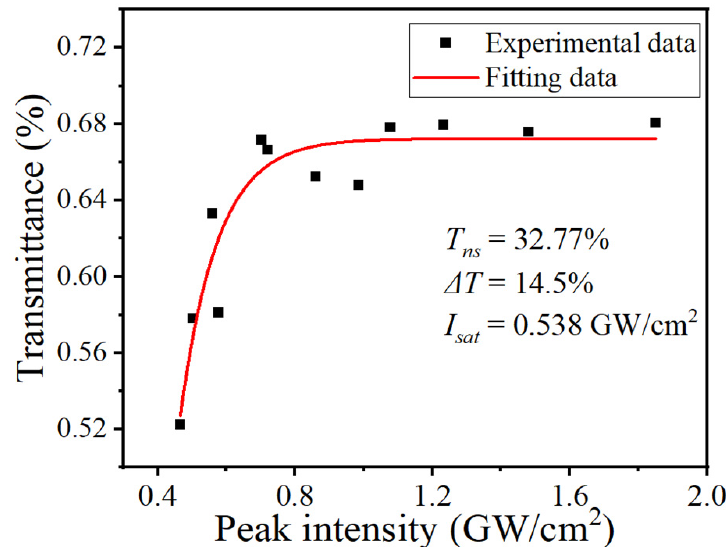
Figure 5. Nonlinear absorption properties of Fe 3 O 4 nanosheets SA.